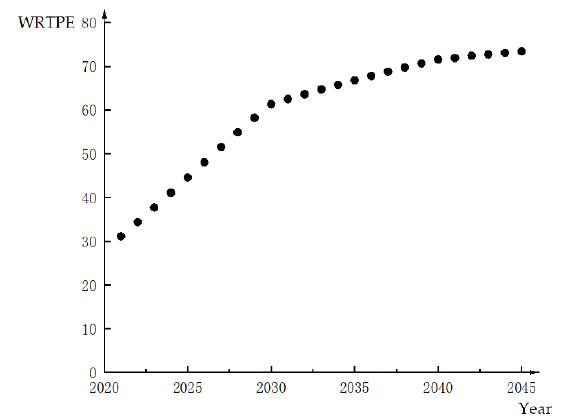
Figure 5. Change trend of WRTPE in Helan.